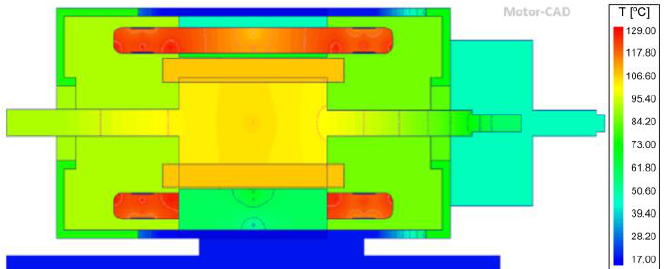
Figure 15. Axial view of water-cooled motor with PA6GF30 casing after FEM analysis.